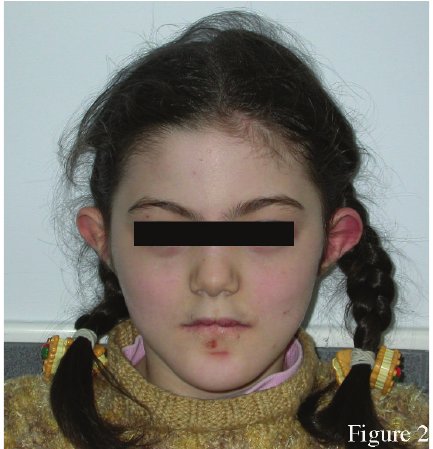
Figure 2: Frontal view of the proband. Note the broad nasal bridge, root, and tip, protruding ears, and bifid